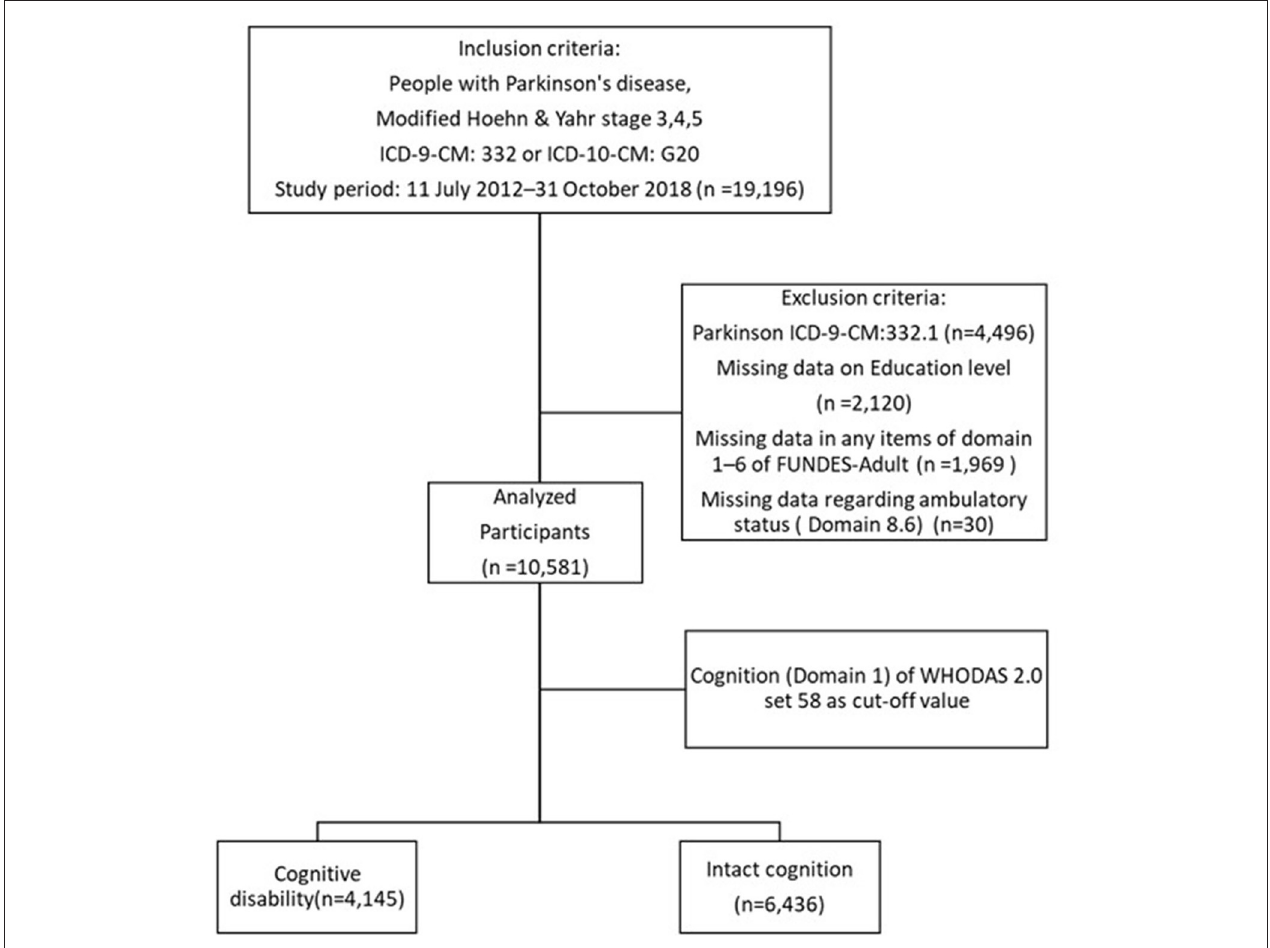
FIGURE 1 | The study participants selection flow